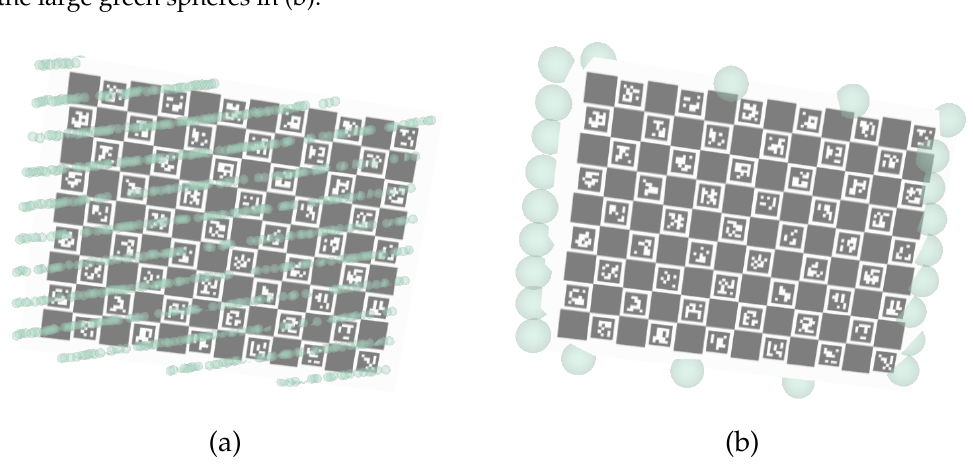
Figure 8. Labeling of 3D LiDAR data: ( a ) LiDAR points labeled as detections; ( b ) LiDAR points labeled as boundary points.